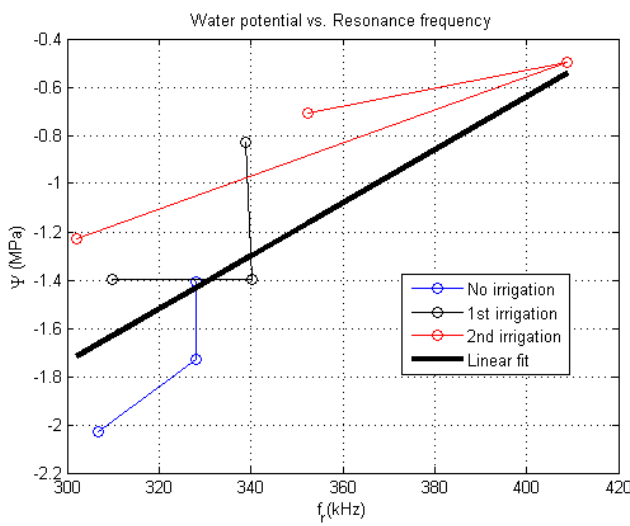
Figure 16. Water potential as function of ultrasonic resonance frequency obtained for 9 different leaves of Coffea arabica under 3 different states of hydration. A linear fit is also included (R = 0.745).